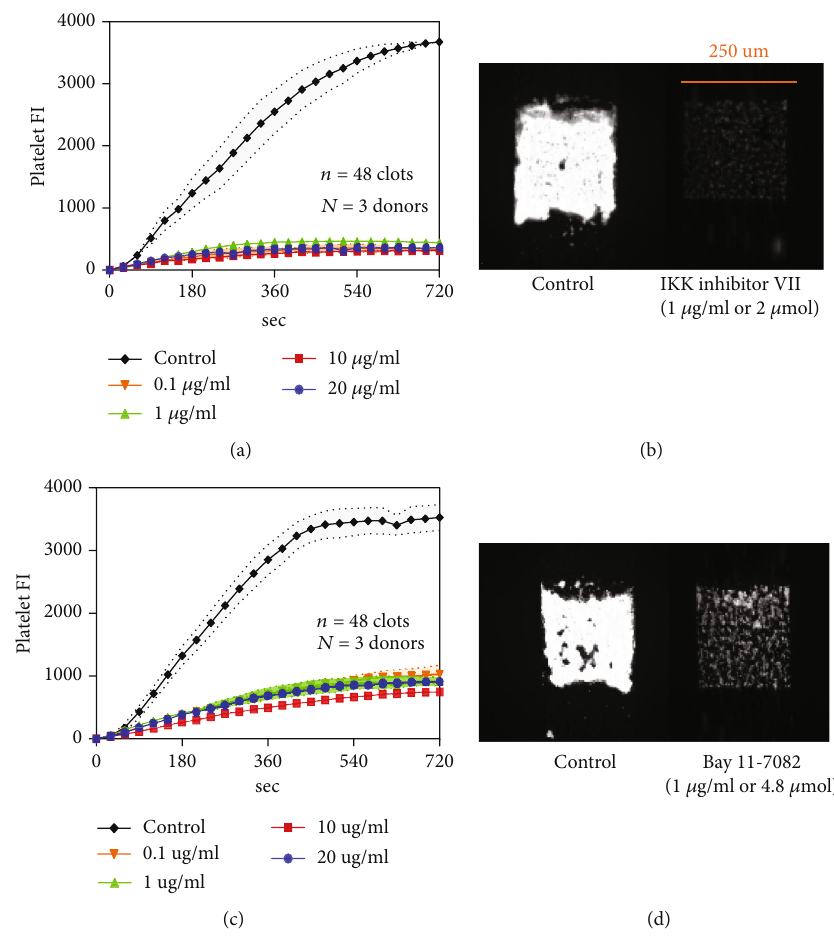
Figure 5: IKK/NF- κ B inhibitors can strongly inhibit platelet deposition under fl ow. PPACK WB with HBS (control) or IKK/NF- κ B inhibitors were perfused over collagen at 100s -1 for 720s. CD61 was added to label platelets. Platelet FI di ff erent concentrations of IKK inhibitor VII (a, b) and Bay11-7082 (c, d) were measured throughout the course of the